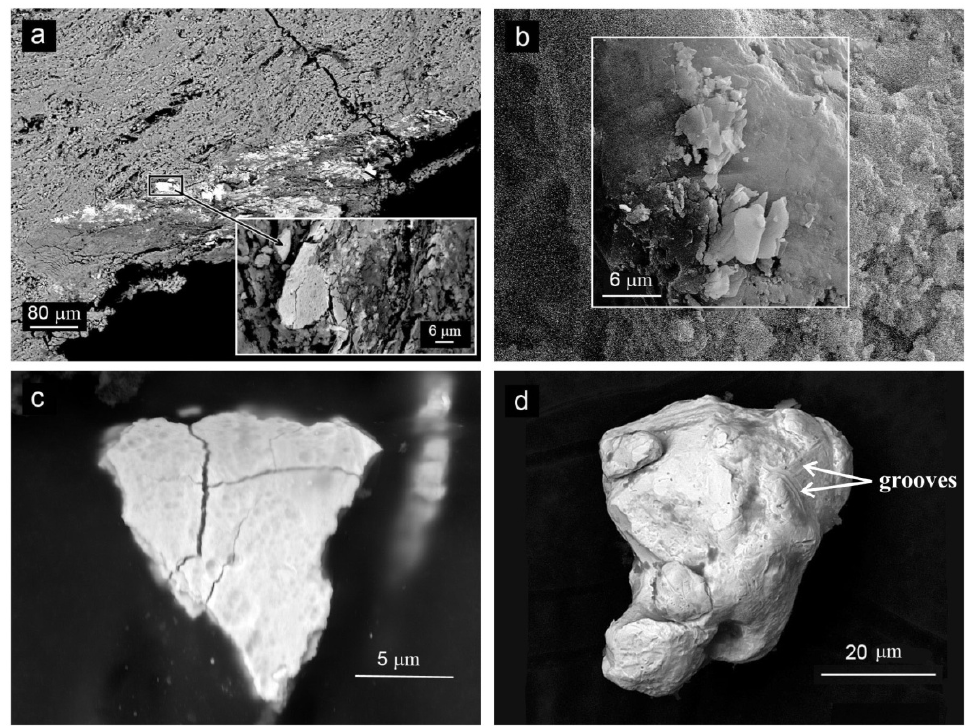
Figure 6. Gold particles in ferromanganese crusts from the Detroit guyot, ( a ): interval of 58–103 mm (Table 2); ( b ): interval of 38–58 mm (Table 2); ( c ): Zubov guyot; ( d ): “Gummi Bear” seamount.